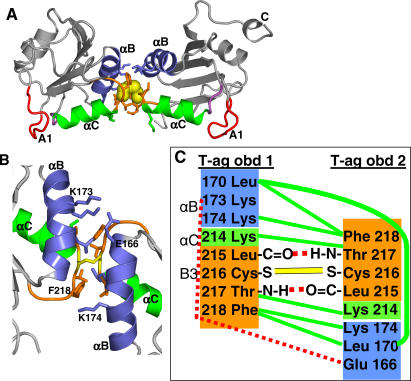
T-ag obd Disulfide-Linked Dimer Structure(A) T-ag obd dimer. Ribbon diagram of the T-ag obd dimer an orientation similar to Figure 2A. The A1 (red), B2 (purple), B3 (orange) loops, helix αB (blue), and helix αC (green) are colored as in Figure 2A. Cys216–Cys216 disulfide linkage is shown as yellow van der Waal spheres.(B) A ribbon diagram of a close-up of the dimer interface using the same coloring as in (A). Side chains of residues that participate in the interface are shown.(C) Schematic of dimer interface. The residues (less than 4 Å apart) involved in the dimer interface are shown. The disulfide bond is shown as a yellow line connecting the two Cys residues. The hydrogen bonds are indicated as red dashed lines, and van der Waals (carbon–carbon) interactions are depicted by solid green lines.